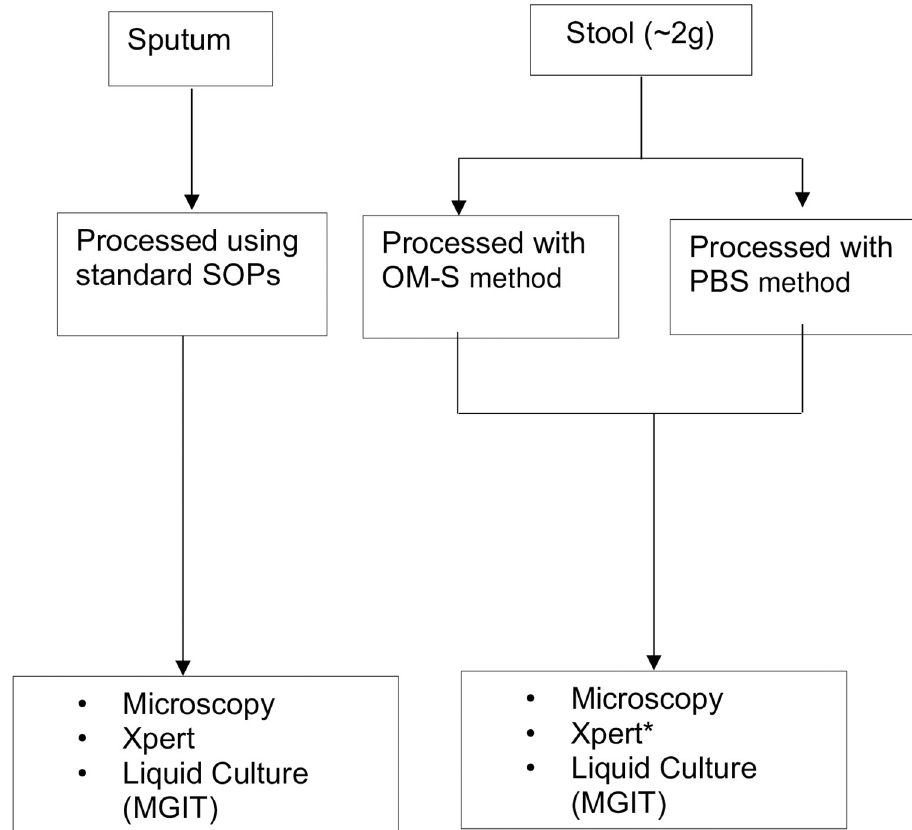
Fig 1. Flow of specimen collection, processing and testing. Legend: MGIT , Mycobacteria Growth Indicator Tube; OM-S , OMNIgene SPUTUM, PBS , Phosphate buffered saline, Xpert * Stool processed by PBS was not tested on Xpert.